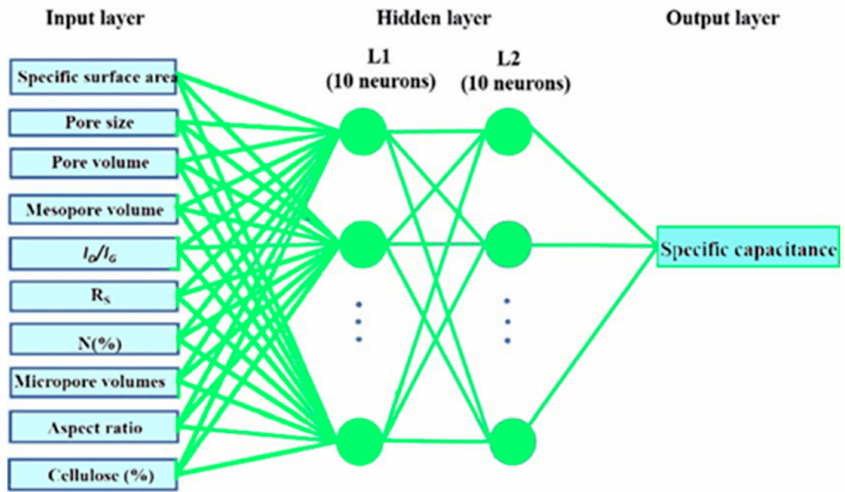
Figure 8. The model overview and diagram of artificial neural